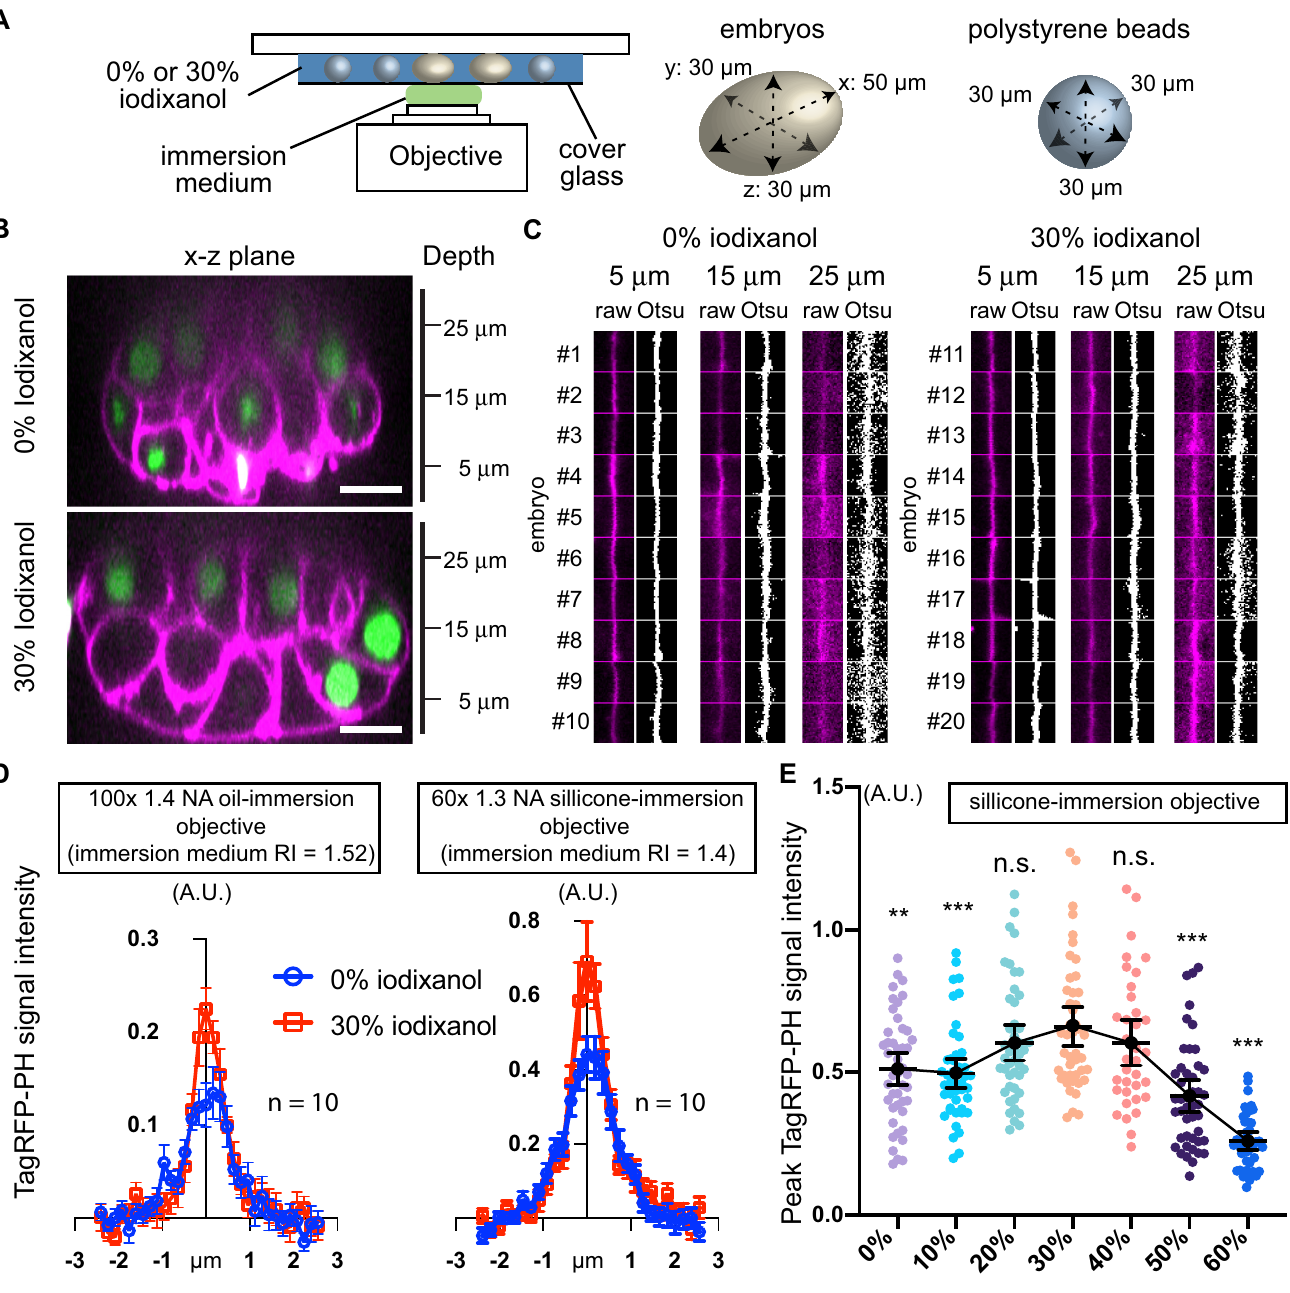
Fig 2. The refractive index matching medium improves the signal intensity in the deeper cell layers. (A) Schematic drawings of the imaging setup. Embryos and embryo-sized polystyrene beads were sandwiched between coverslips and glass slides to prevent embryo flotation due to the higher density of iodixanol solution. (B, C) Depth-induced blurring of the cell-cell boundary. Spinning-disk confocal images of 24-cell stage embryos (B). Magenta, TagRFP-PH (plasma membrane); green, histone H2B-GFP (chromosomes). Plasma membrane signal at the cell-cell boundary (C). Each raw image in C, which captures a cell-cell boundary in 4.96 μ m x 4.96 μ m area, was converted into binary images using Otsu’s method. (D) Intensity profiles of cell boundaries. A line passing a cell-boundary at 25- μ m depth was used to measure intensity profiles of TagRFP-PH. The background level was adjusted to zero (see S4A Fig for detail). Error bars are standard errors of means. (E) Peak Tag RFP-PH signal intensity at 25- μ m depth in different iodixanol concentrations. Error bars are 95% confidence intervals. Statistical test was performed by comparing samples treated with 30% iodixanol and others. P-values were calculated by one-way ANOVA with the Holm-Sidak’s multiple comparison test. n.s. (P > 0.05), �� (P < 0.001), and ��� (P < 0.0001). All depths shown are relative to the cell surface closest to the objective lens. Scale bars, 10 μ m.